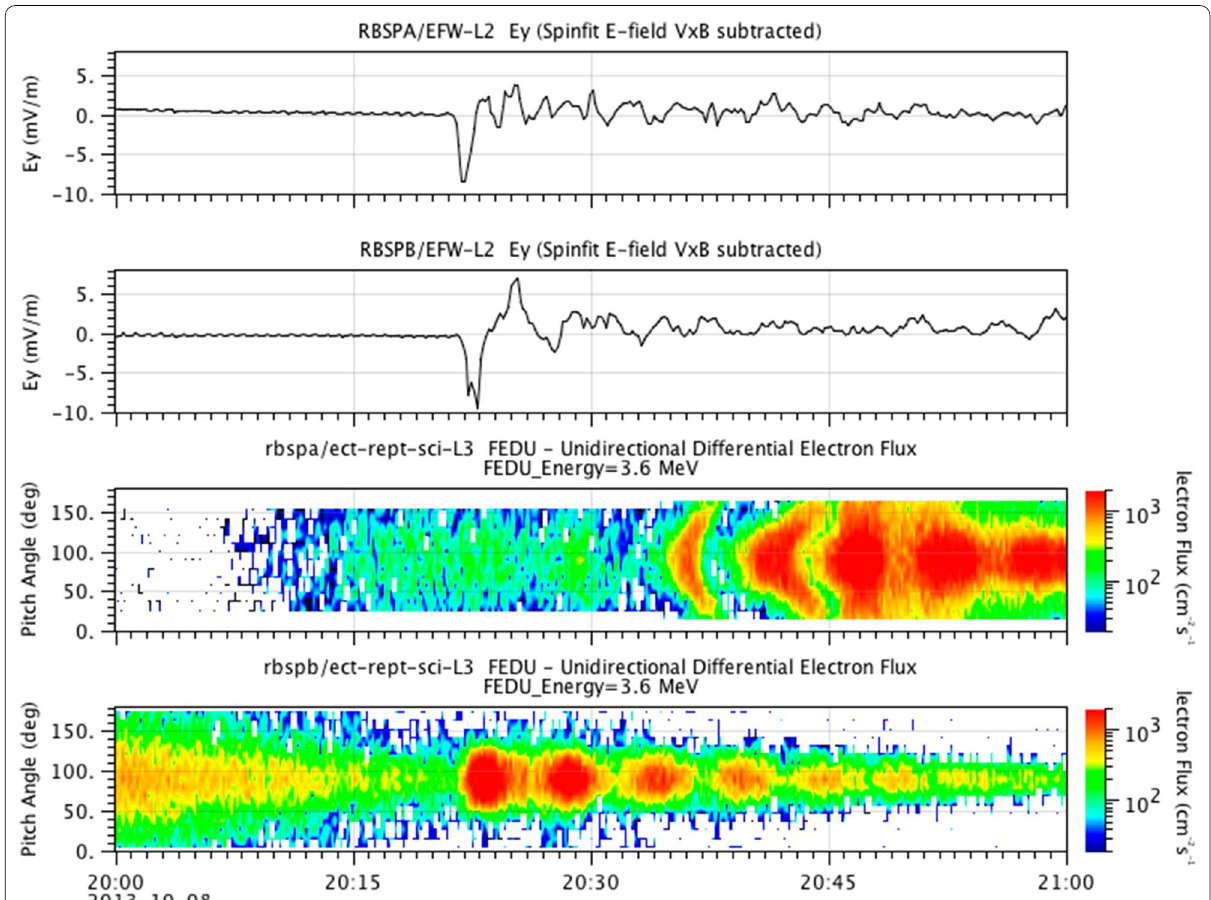
Fig. 2 Relativistic electron flux increases in the 3.6 MeV channel from the REPT instrument on Van Allen Probes A and B is shown. (top) The shock-driven electric field at each spacecraft is included for reference. (bottom) Measurements of electron flux in the 3.6 MeV REPT channel are shown as functions of pitch angle and time from each of the two probes (From Foster et al.